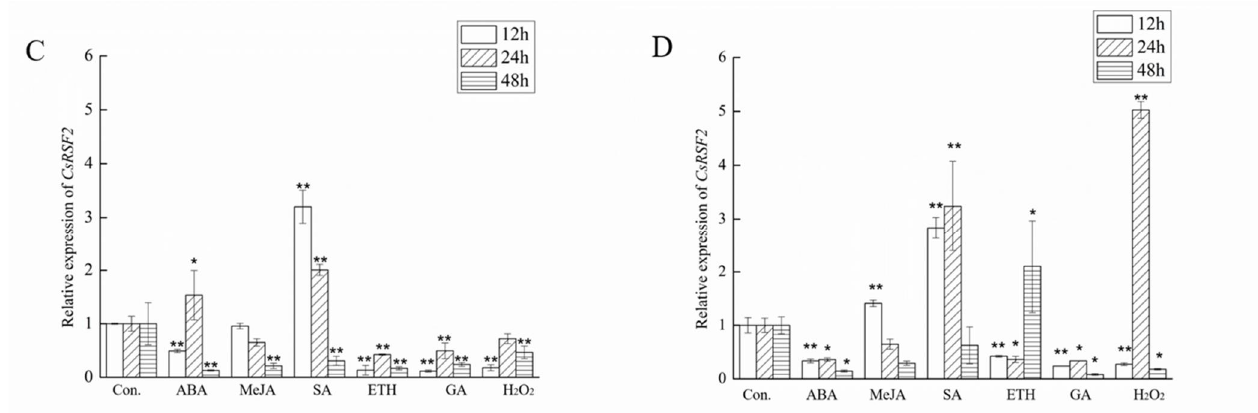
Figure 3. Expression patterns of CsRSF1 and CsRSF2 genes under exogenous substances. These exogenous substances include 100 µmol·L −1 abscisic acid (ABA), 100 µmol·L −1 jasmonate (MeJA), 1 mmol·L −1 salicylic acid (SA), 10 µL·L −1 ethephon (ETH), 100 mg·mL −1 gibberellin (GA), 10 µmol·L −1 hydrogen peroxide (H 2 O 2 ). ( A ) qRT–PCR analyses of CsRSF1 transcripts in the resistant cultivar. ( B ) qRT–PCR analyses of CsRSF1 transcripts in the susceptible cultivar. ( C ) qRT–PCR analyses of CsRSF2 transcripts in the resistant cultivar. ( D ) qRT–PCR analyses of CsRSF2 transcripts in the susceptible cultivar. The relative expression levels of CsRSF1 and CsRSF2 in cucumber plants at various time points (12 h, 24 h, 48 h) were compared with the mock control, which was set to 1. Expression analysis of candidate genes using the 2 −ΔΔ C t method. Data are means ± standard deviations (SD) from three biological replicates per cultivar. The asterisks indicated a signifi- cant difference (Student ’ s t -test, * p < 0.05 or ** p < 0.01).